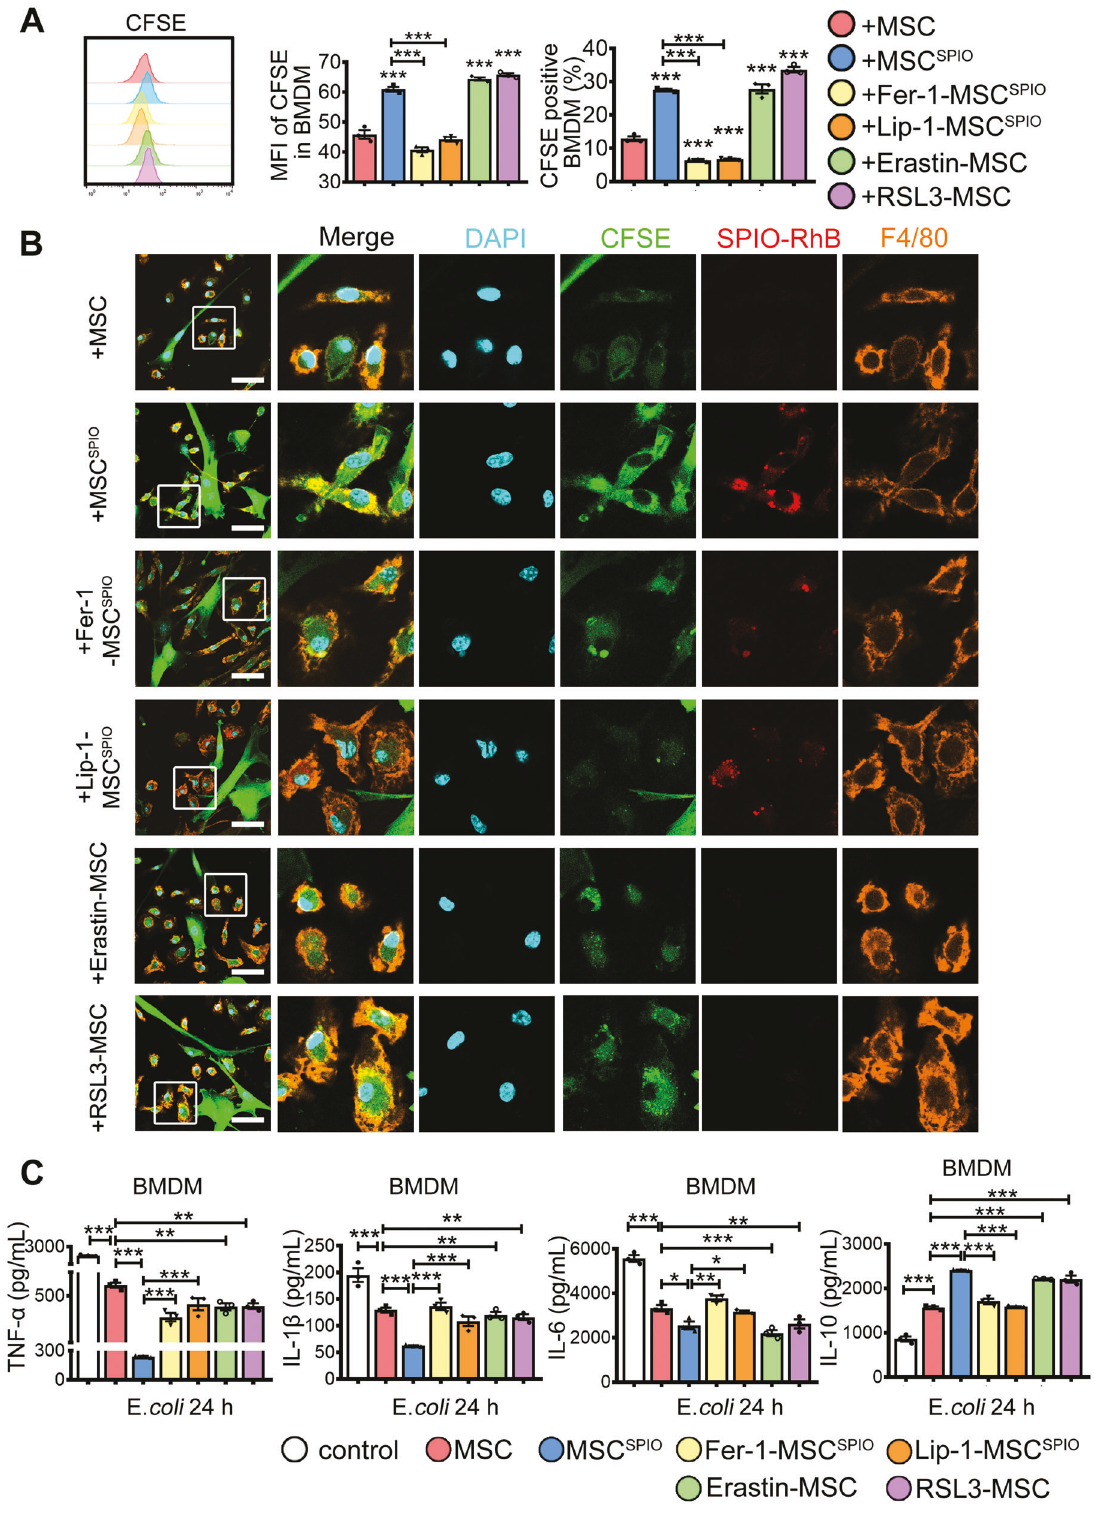
Fig. 5 MSC SPIO promotes the efferocytosis of macrophages via ferroptosis. MSCs, MSC SPIO , MSC SPIO pretreated with Fer-1 (10 μ mol/L) or Lip- 1 (20 μ mol/L), MSCs pretreated with Erastin (100 nmol/L) or RSL3 (10 nmol/L) were co-cultured with BMDM. A , B Phagocytosis of BMDM from each group was determined by A fl ow cytometry and B confocal microscope at 24 h. C BMDM from each group were stimulated with E . coli for 24 h, and BMDM without co-culture were used as control. Cytokines production of TNF- α , IL-1 β , IL-6, and IL-10 was determined by ELISA. Data are shown as mean ± SEM ( n = 3). * p < 0.05; ** p < 0.01; *** p < 0.001.